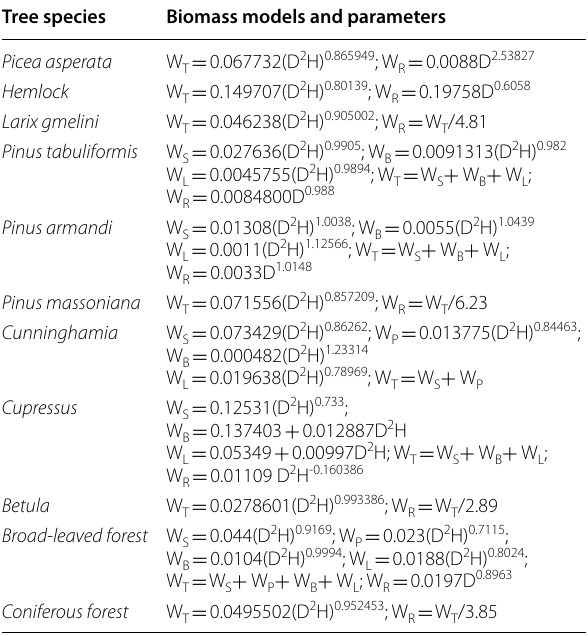
Table 1 Biomass models and parameters of different trees.